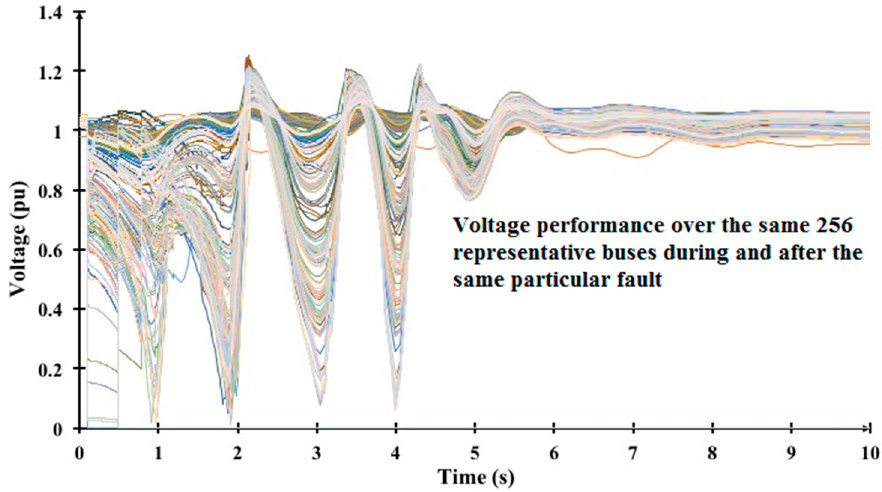
Figure 10. Voltage sags for dispatch SLL 2 .